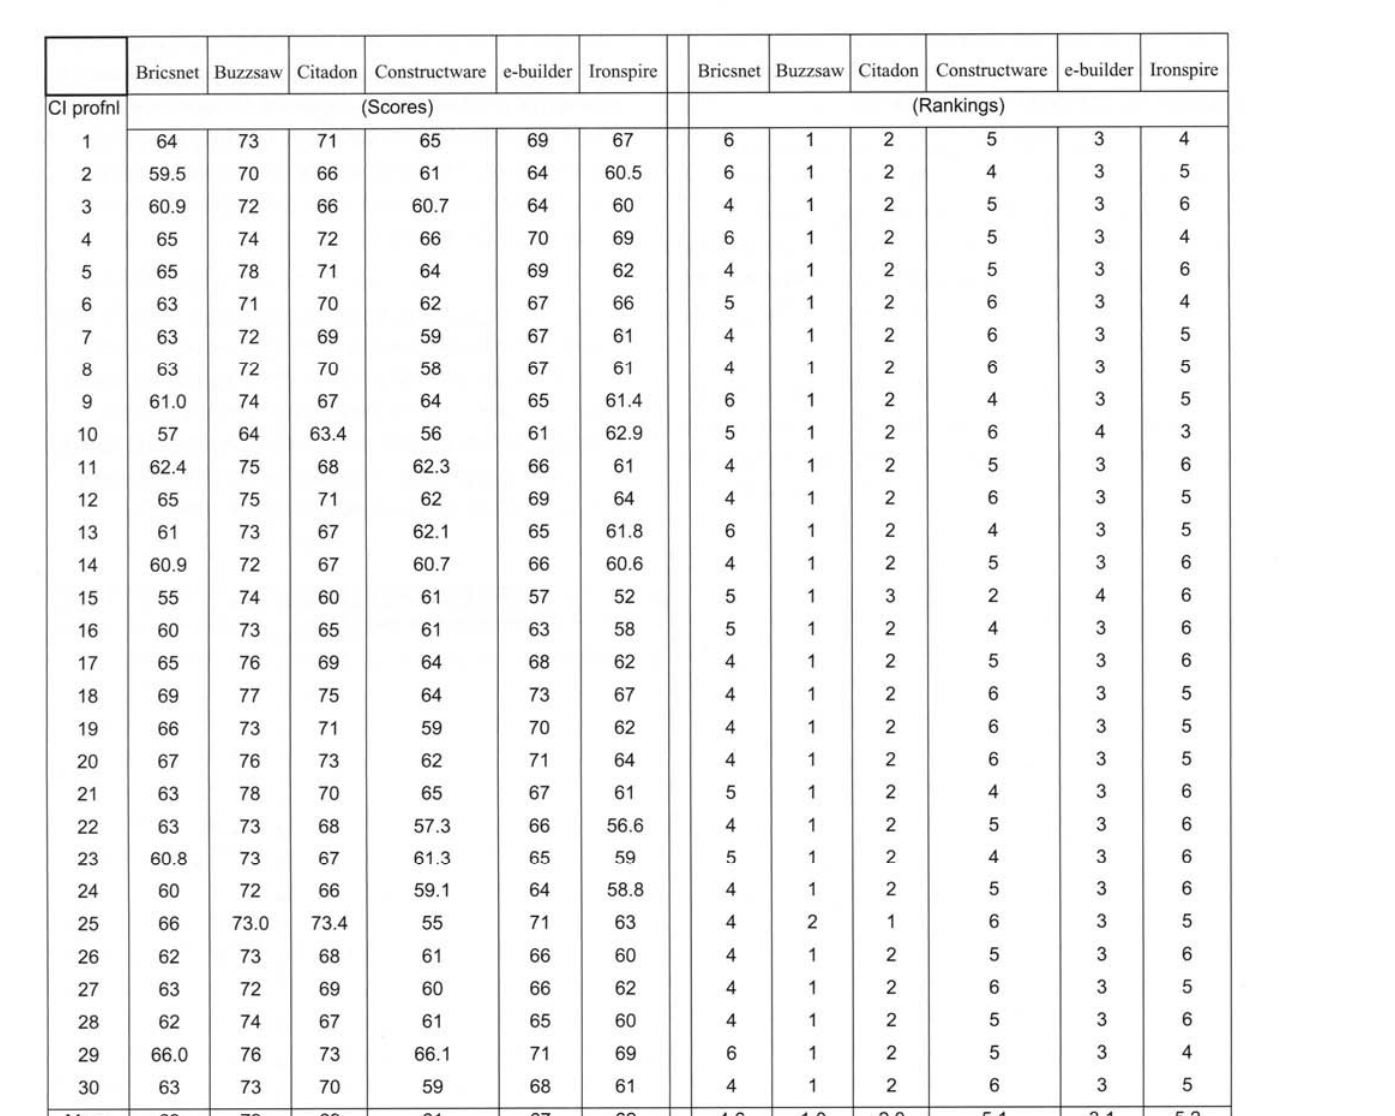
Table 2: Scores and rankings calculated using construction personnel's weightings without including cost. All but one of the results give the same package the first ranking, similarly, the same package was consistently ranked second.